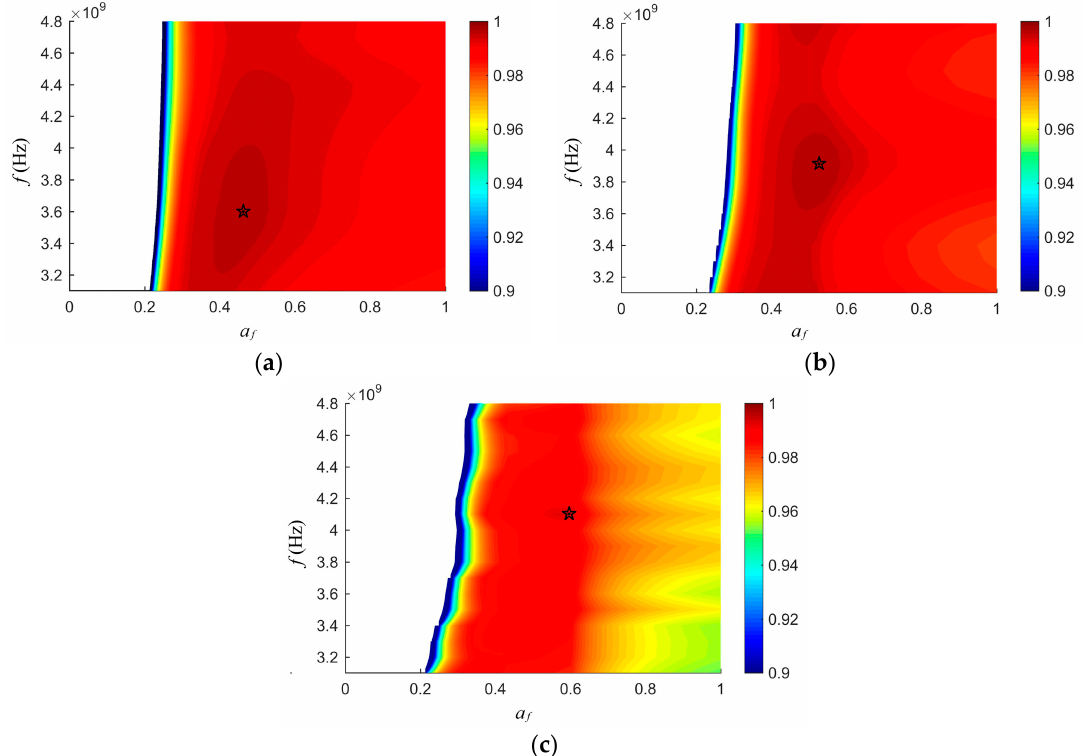
Figure 11. The frequency factor f a and f dependence of the value of the objective function (17): ( a ), wheat; ( b ), rough rice; ( c ), barley. The blank region on the left side of the figure was the forbidden region. When a f was too small, the expression ε (cid:48)(cid:48) / ε was smaller than zero, which made ψ an imaginary number. It was meaningless that ψ was an imaginary number, so the blank region on the left side of the figures indicated the forbidden region. The pentagram in each figure denotes the optimal combination of f a and f . It can be seen there is the best combination for each type of grain, and the optimal values are shown in Table 2.